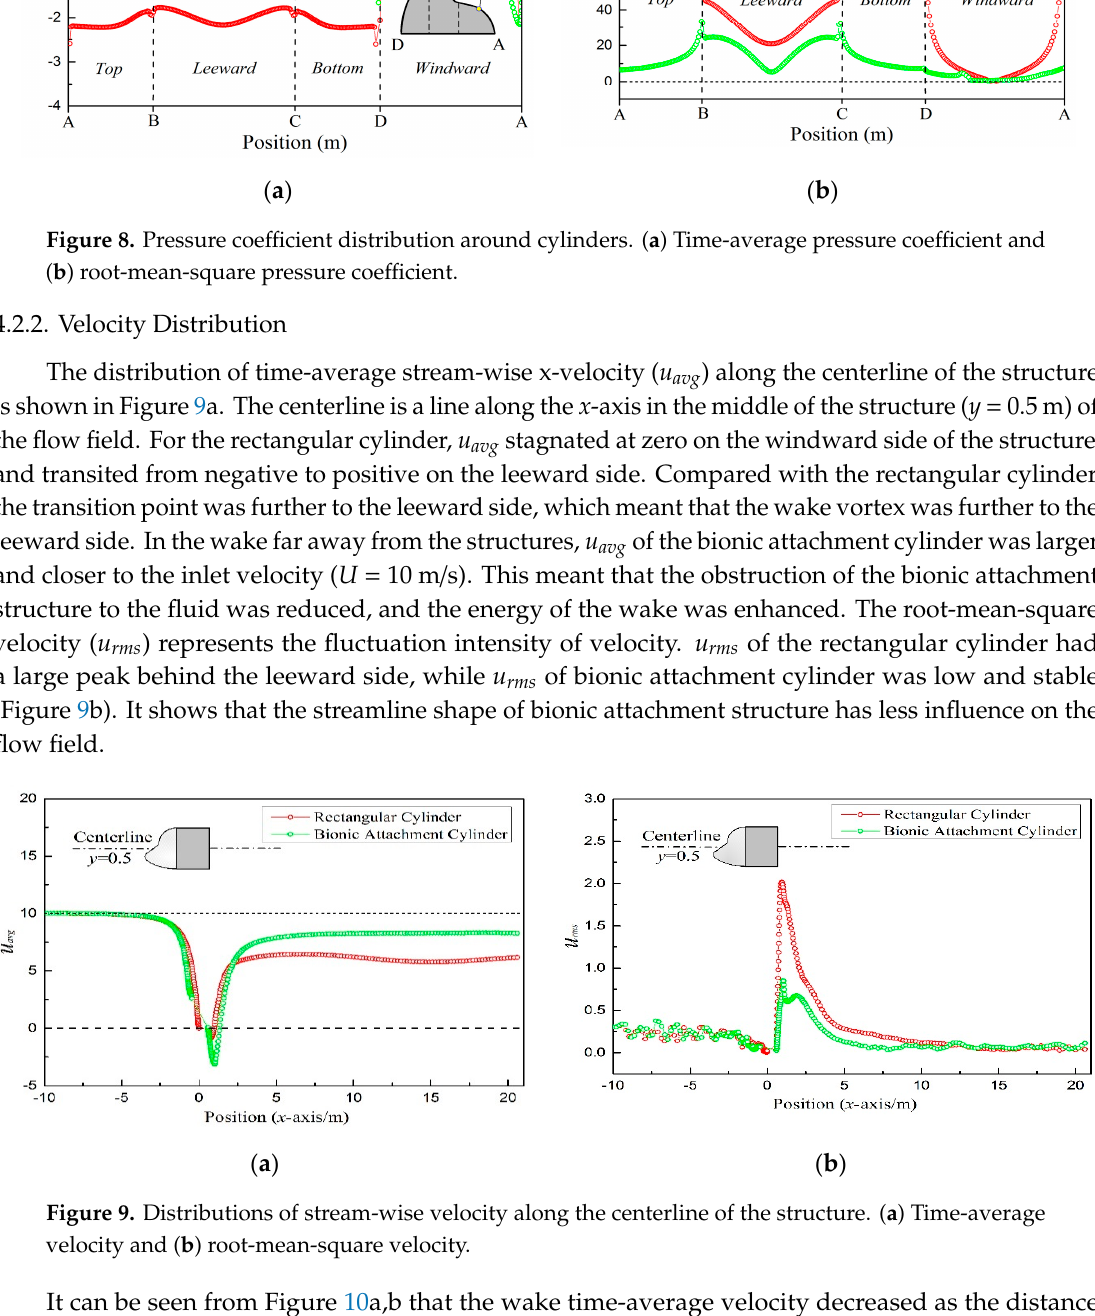
Figure 8. Pressure coefficient distribution around cylinders. ( a ) Time-average pressure coefficient and ( b ) root-mean-square pressure coefficient.